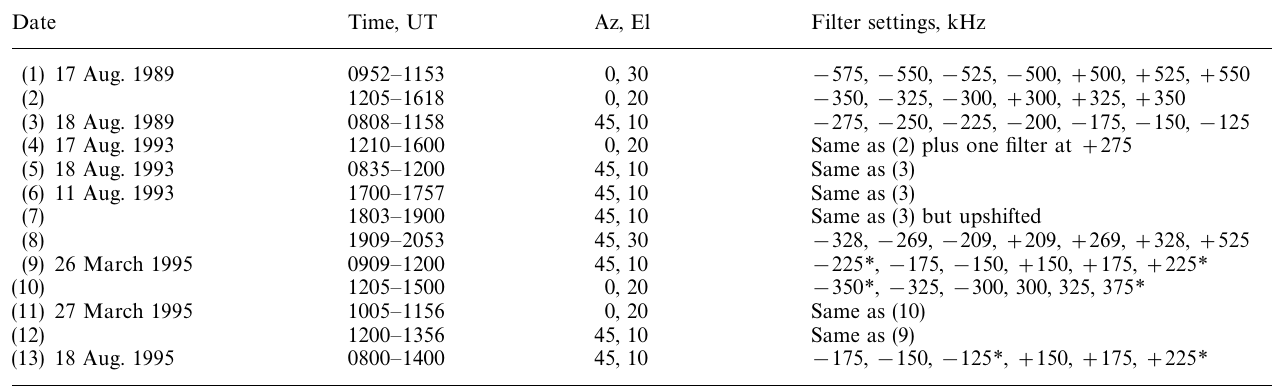
Table 1. Antenna azimuth, Az, and elevation, El, together with receiver-filter settings, for the experiments. The # and ! signs denote upshifts and downshifts, respectively, relative to the transmit- ted frequency. Asterisks denote filters with a $ 25-kHz bandpass. All